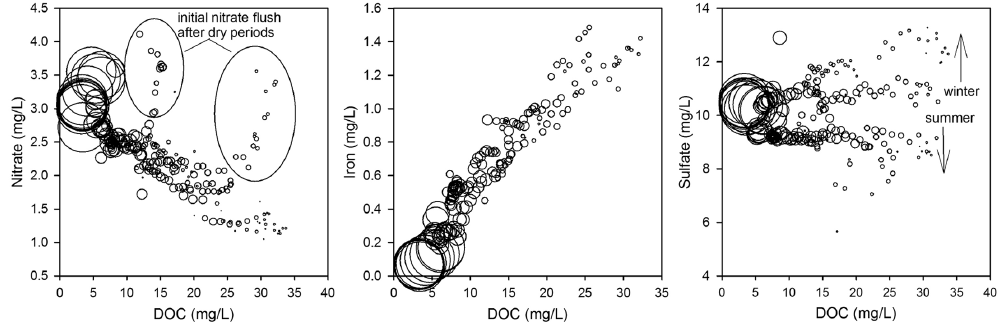
Fig. 6. Plots of DOC concentrations versus nitrate, iron and sulfate from the one year dataset of this study. The size of the open circles represents the depth of the groundwater table at the specific point of time, with largest circles meaning a groundwater table depth of 62cm below surface and smallest dots a groundwater table depths of 2cm below surface at the reference well. Note that deviations from the linear relationship of DOC with nitrate occurred at high rainfall after dry conditions, causing an initial nitrate flush (see Fig. 2, upper graphs). For sulfate, the correlation tended to be negative in summer (presumably due to reductive elimination in wetlands), while positive in winter (less reducing activity in wetlands and more surface